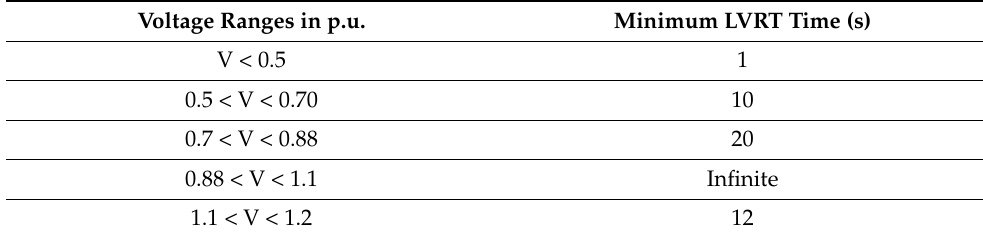
Table 5. IEEE 1547 Voltage ride ‐ through requirement. Voltage Ranges in p.u.